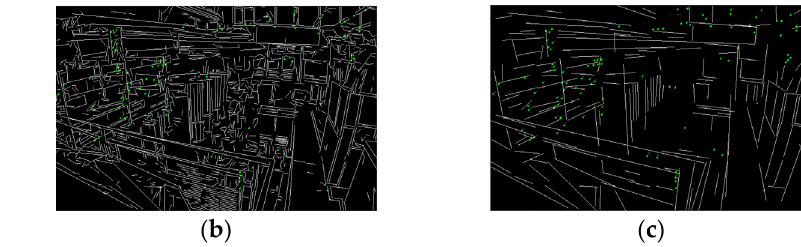
Figure 2. Comparison of the effects of the two algorithms: ( a ) EuRoC datasets scene; ( b ) traditional LSD + KLT optical flow; ( c ) the effect of our algorithm.